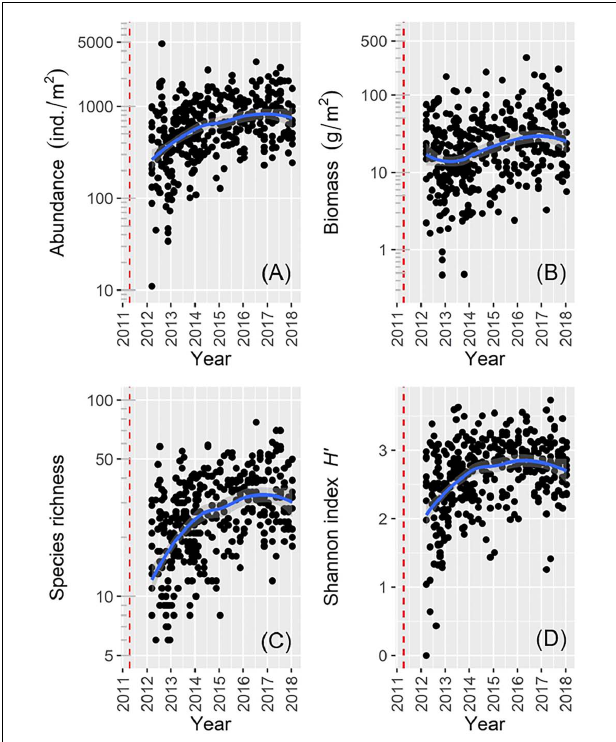
FIGURE 2 | Scatter plots showing general temporal trends of macrofaunal data for: (A) abundance; (B) biomass; (C) species richness; (D) Shannon’s index H (cid:48) (the red dotted line denotes the date of the 2011 disaster).